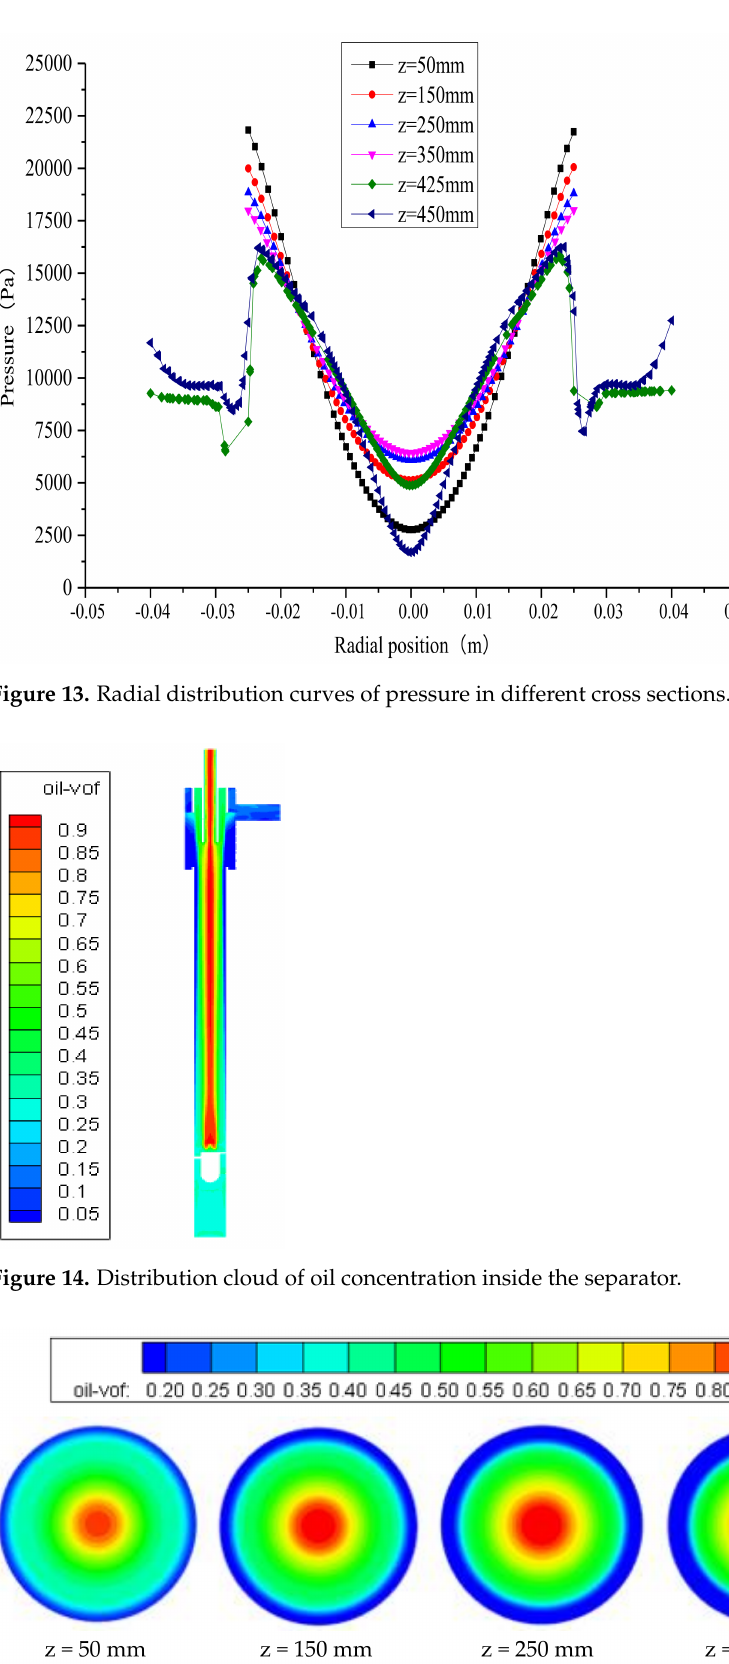
Figure 15. Distribution cloud of oil concentration in different cross